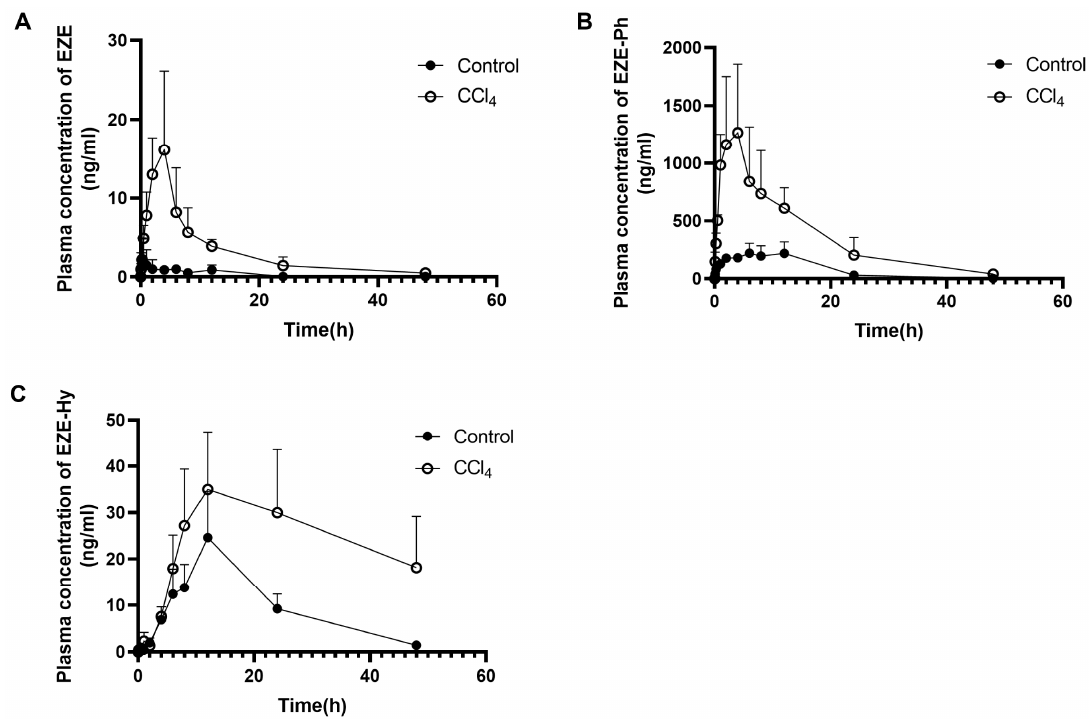
Figure 4. Mean plasma concentration–time profiles of EZE ( A ), EZE-Ph ( B ), and EZE-Hy ( C ) following oral administration of 10 mg/kg EZE to control and CCl 4 -induced rats. Each point was presented as mean ± S.D. ( n = 5).